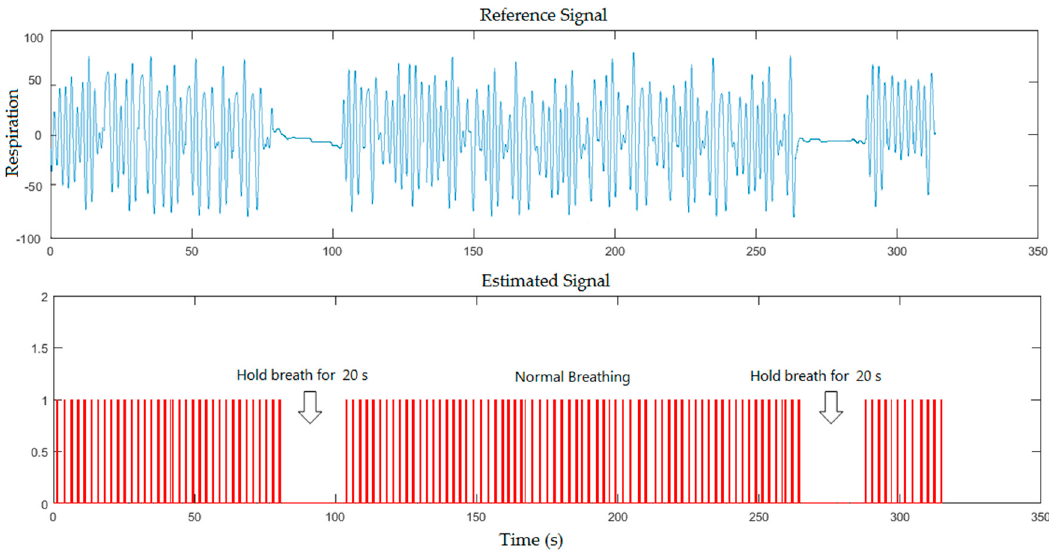
Figure 8. A five minutes simulation for healthy subject where the subject was asked to hold his breath twice during the measurement for the second scenario (with a blanket).